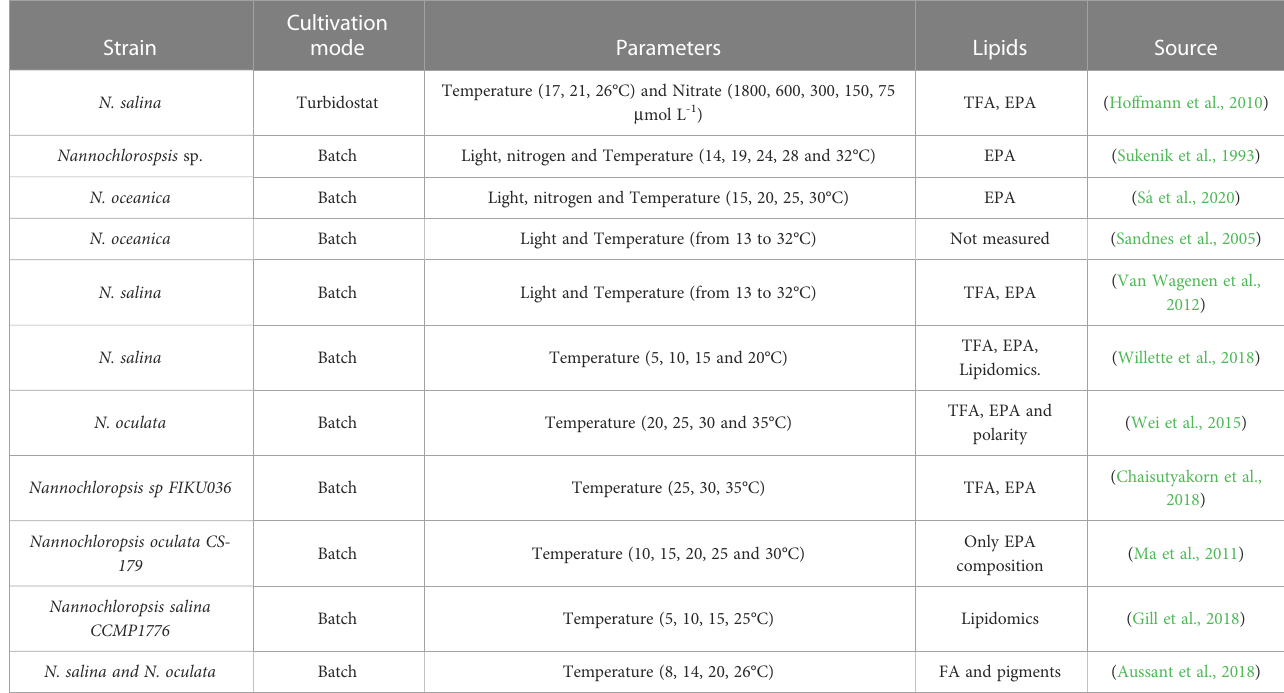
TABLE 1 Overview of studies evaluating the temperature effect on lipids from Nannochloropsis species.